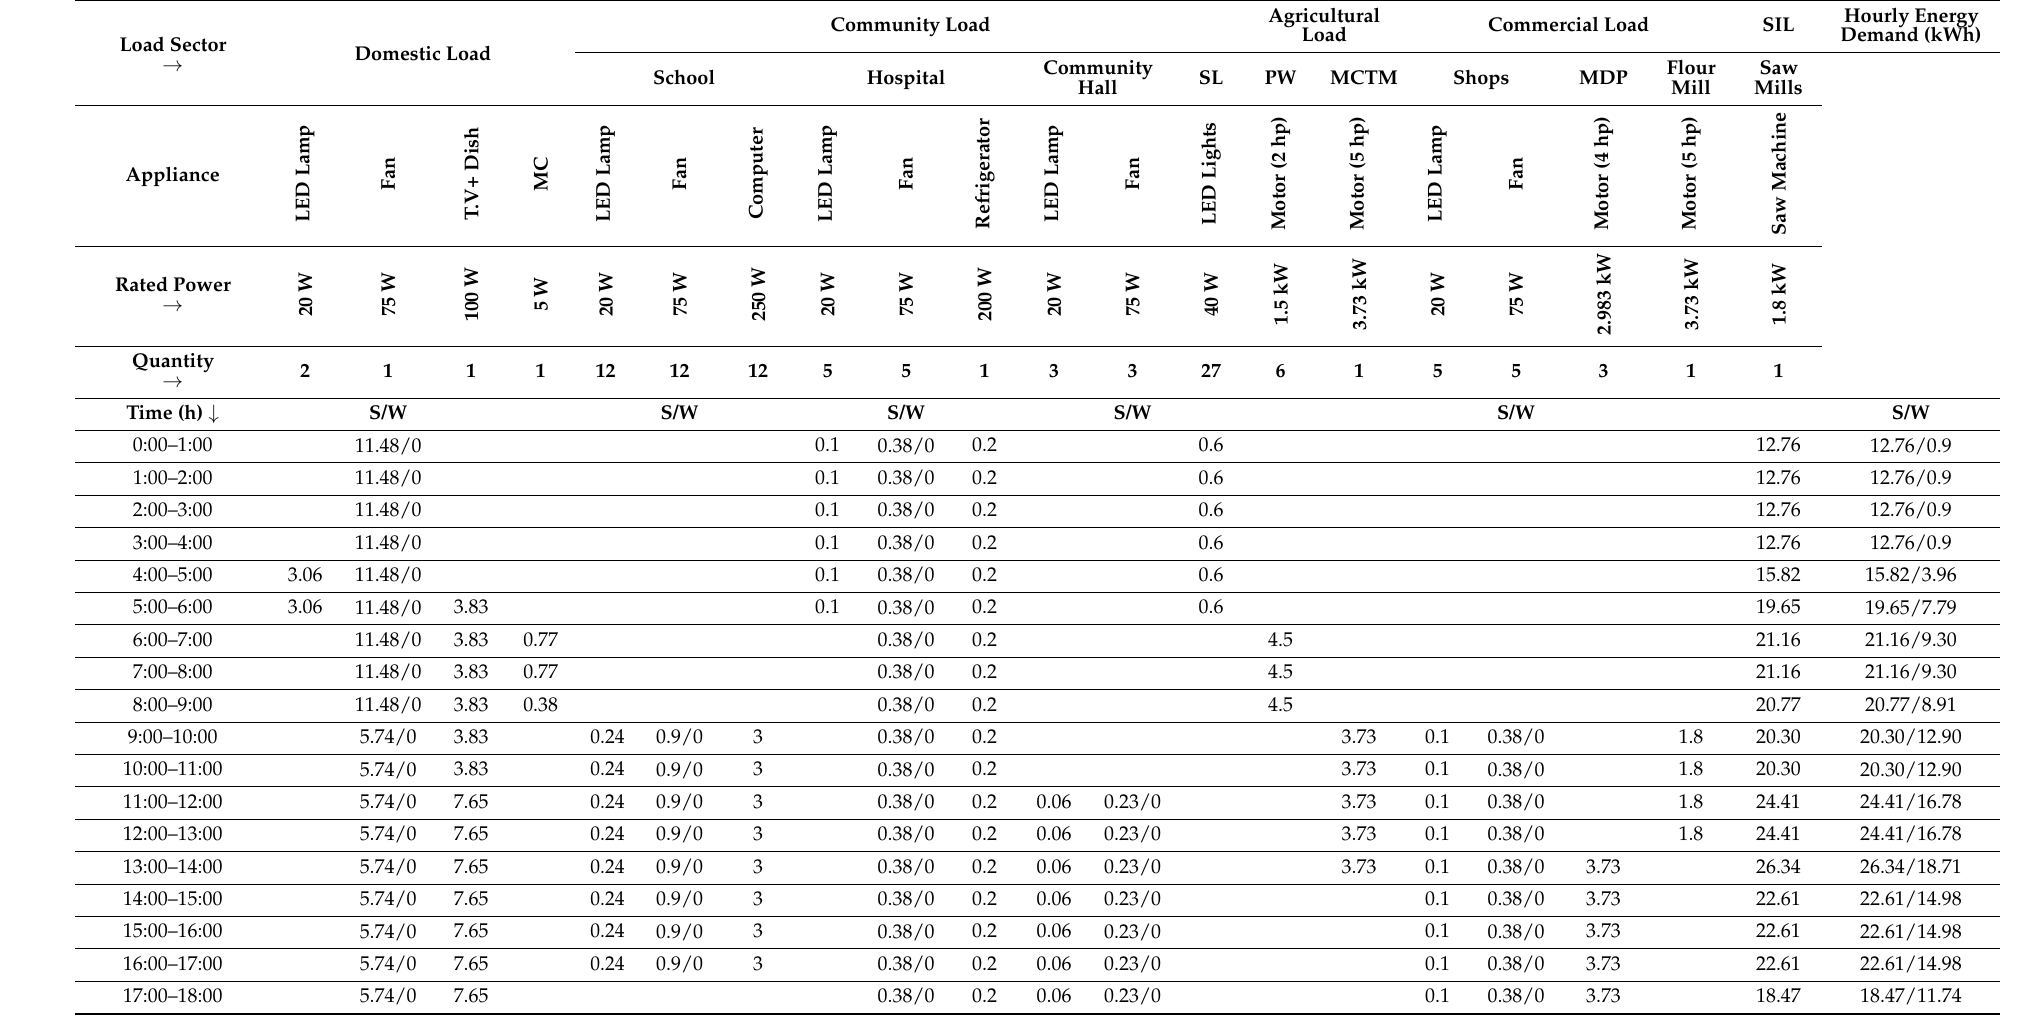
Table 1. Complete information on the study area’s load